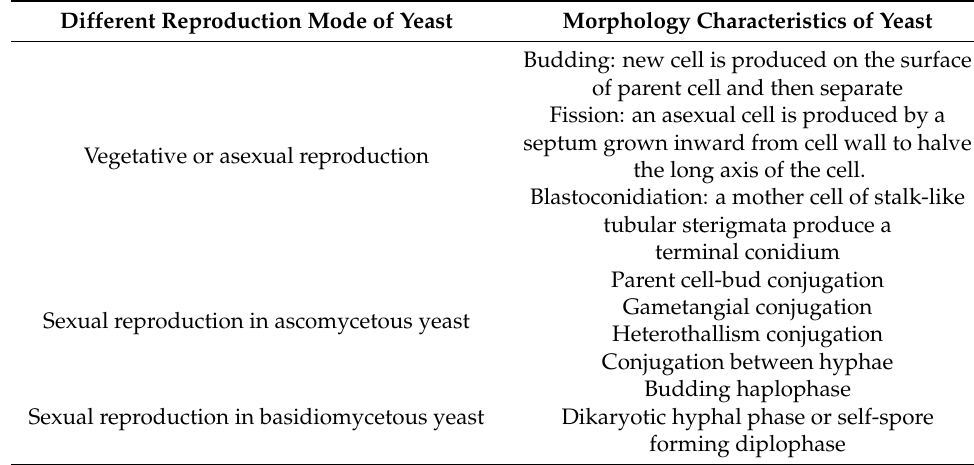
Table 6. Morphology of yeast isolated from